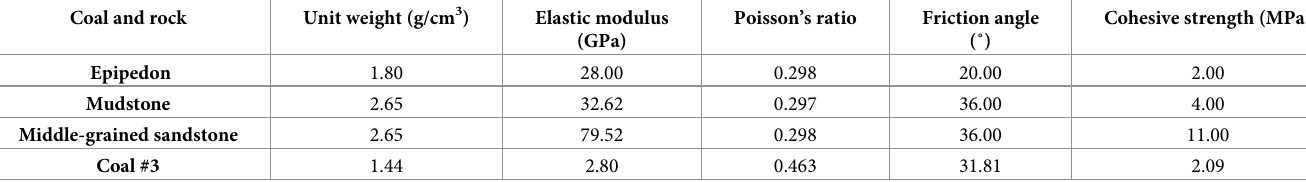
Table 1. Mechanical parameters outside the collapse